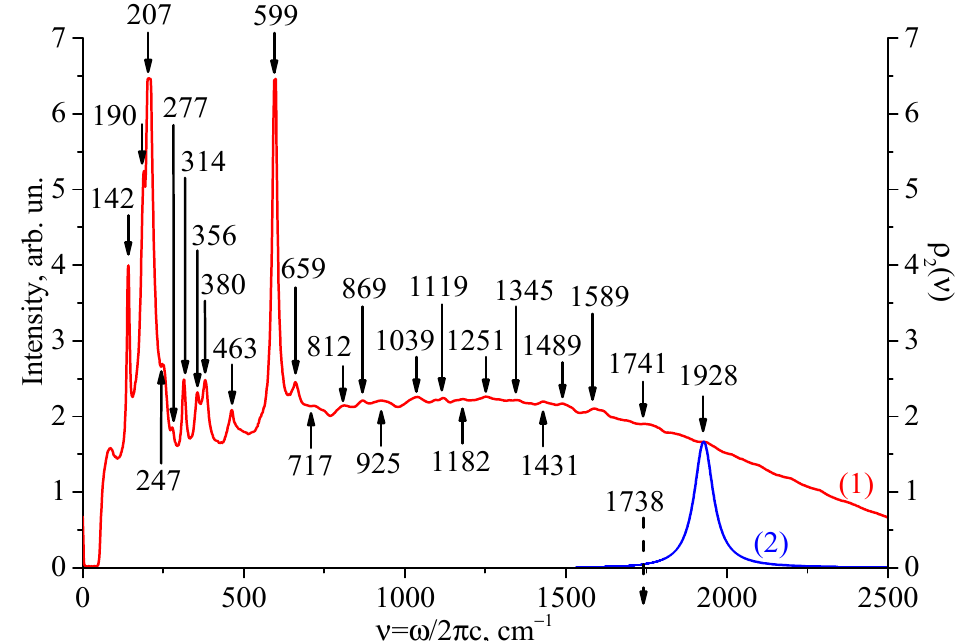
Figure 4. Comparison of the real Raman spectrum of the LT:Cr crystal (curve 1) with the calculated dependence of the two-phonon state density ρ 2( ν ) in the overtone region (curve 2).